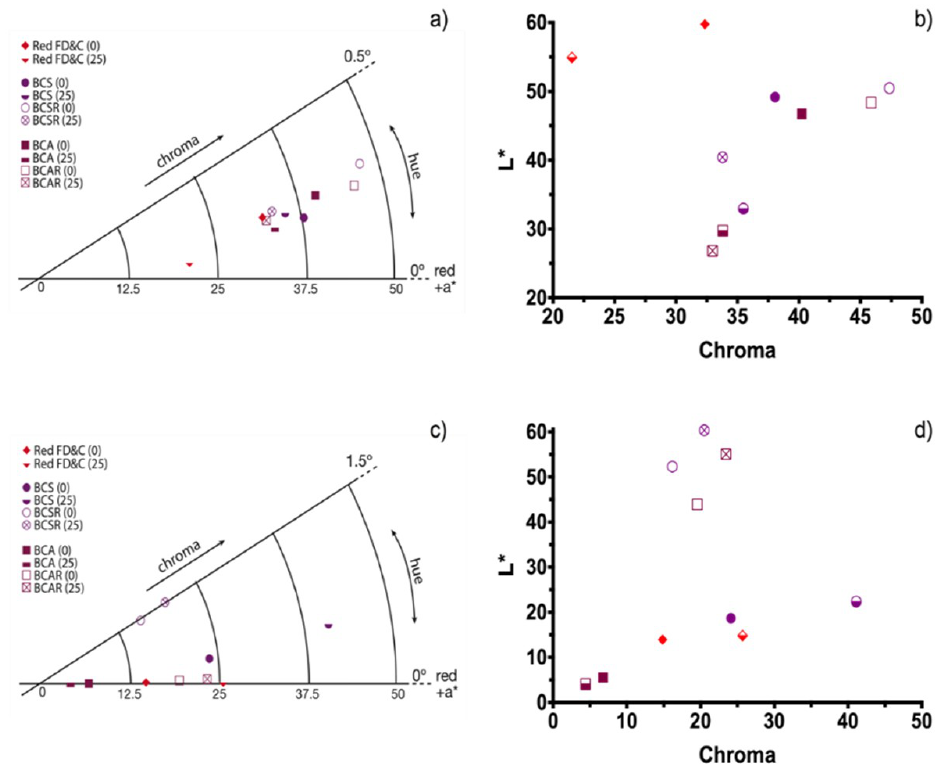
Figure 8. ( a , c ) Sectional polar and ( b , d ) cartesian diagram of color for the black carrots extracts and the red FD&C on food models (yogurt and jelly) at 0 and 25 days of storage. As seen in Table 2, after the 25-day storage time the color differences ( ∆ E) in yogurt, of all samples, have values higher than five, which indicates that the color difference at the beginning and after the elapsed time is visually evident; also, samples have higher saturation (lowest chroma value) after storage and specifically the black carrots extract samples get darker since L* value is lower. BCS samples showed similar color difference after storage time compared with red